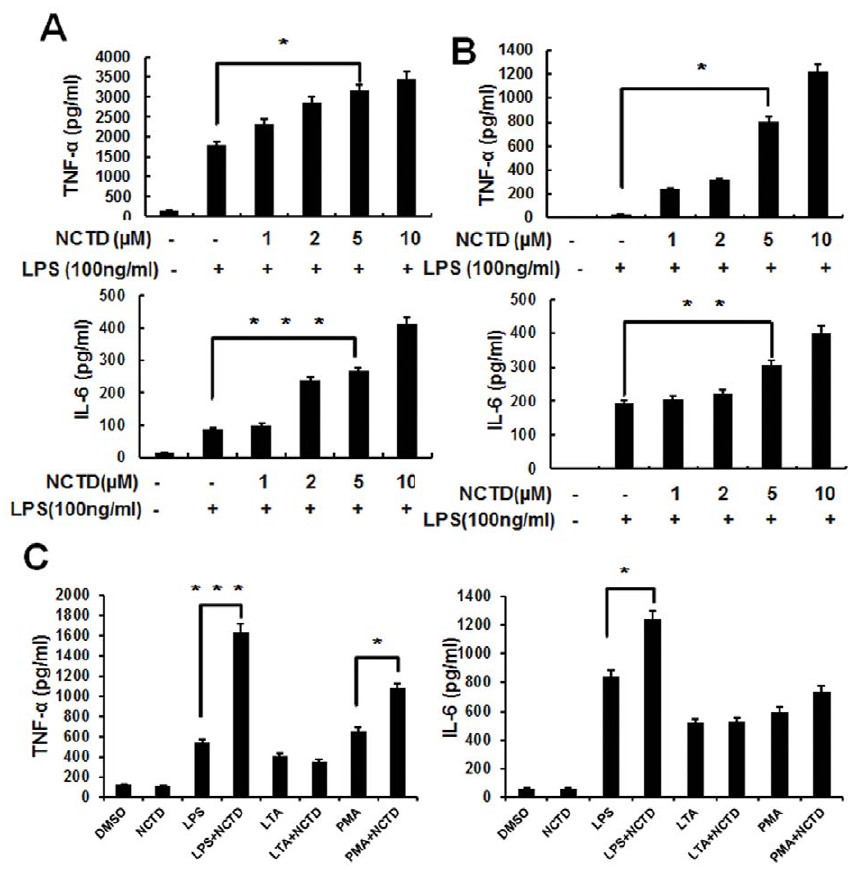
Figure 3. NCTD enhances production of pro-inflammatory cytokines in RAW264.7 and BMMs. A–B, RAW264.7 cells (A) and BMMs (B) were pretreated with PBS (containing 0.1% DMSO) or 1–10 m M NCTD for 24 h and activated with 100 ng/ml LPS for 6 h. The culture supernatants were then collected and analyzed by ELISA for cytokine production. C, Only LPS induced cytokine production was enhanced by NCTD obviously. The RAW264.7 cells were pretreated with 0.1% DMSO, 5 m M NCTD for 24 h before stimulation with LPS (100 ng/ml), PMA (100 nM) or LTA (10 m g/ml) for 6 h. The culture supernatants were then collected and analyzed by ELISA for cytokine production. Columns, means from three independent experiments with three duplicates; bars, SE (*, P , 0.05; **, P , 0.01 versus